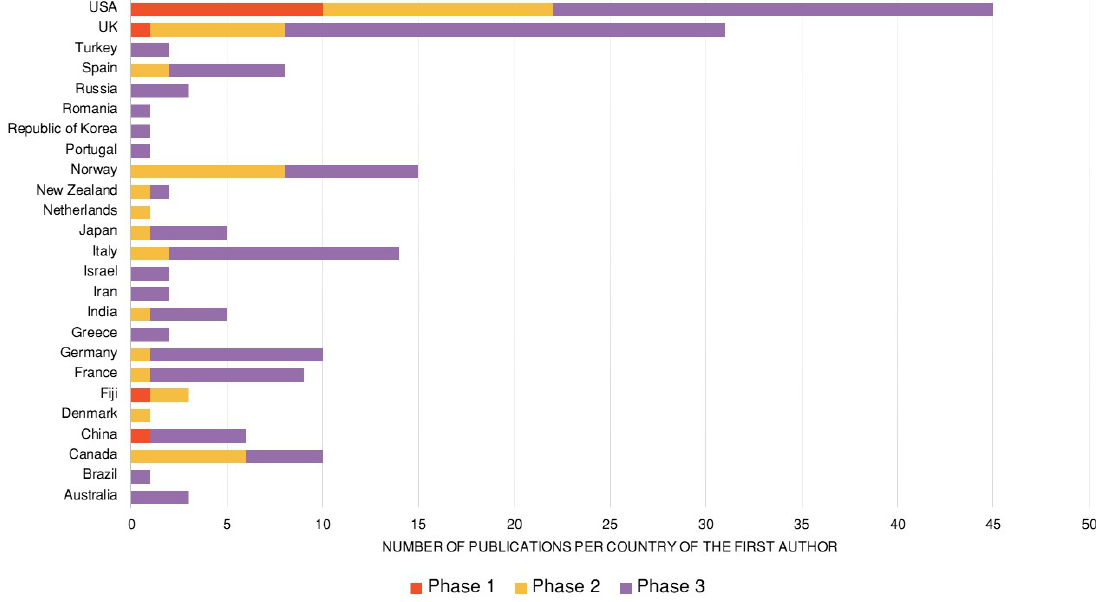
Figure 7. Number of articles per country of the first author during three phases over the 35-year period analyzed.